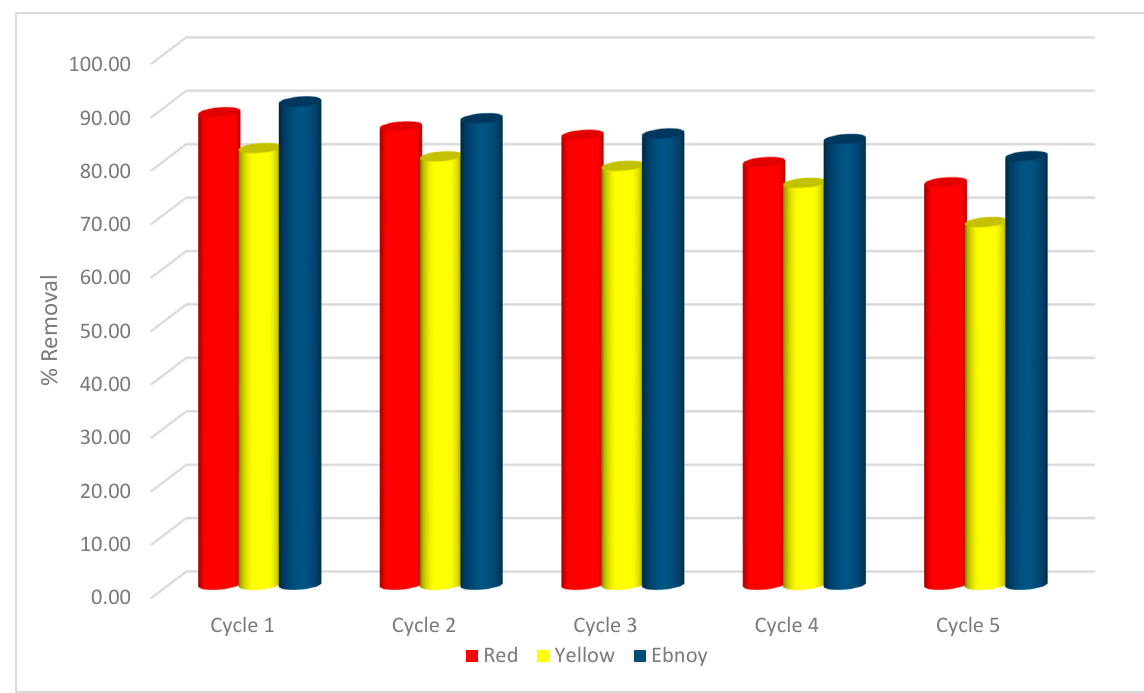
Figure 18. Removal Percentage of R, Y, and E in Regeneration process of COZ adsorbent. The desorption of R and Y is related to the established weak electrostatic attraction between the carboxyl group in acetic acid and cationic dyes, which was beneficial for reducing the interaction between dyes (R and Y) and ZnO. The same justification applies to the reaction of acidic E dye with NaOH base. The pH of the solution is another feature that promotes dye desorption processes. The adsorbent surface turns positive (ZnOH 2+ ) when pH < pH pzc and negative (ZnO − ) when pH > pH pzc .